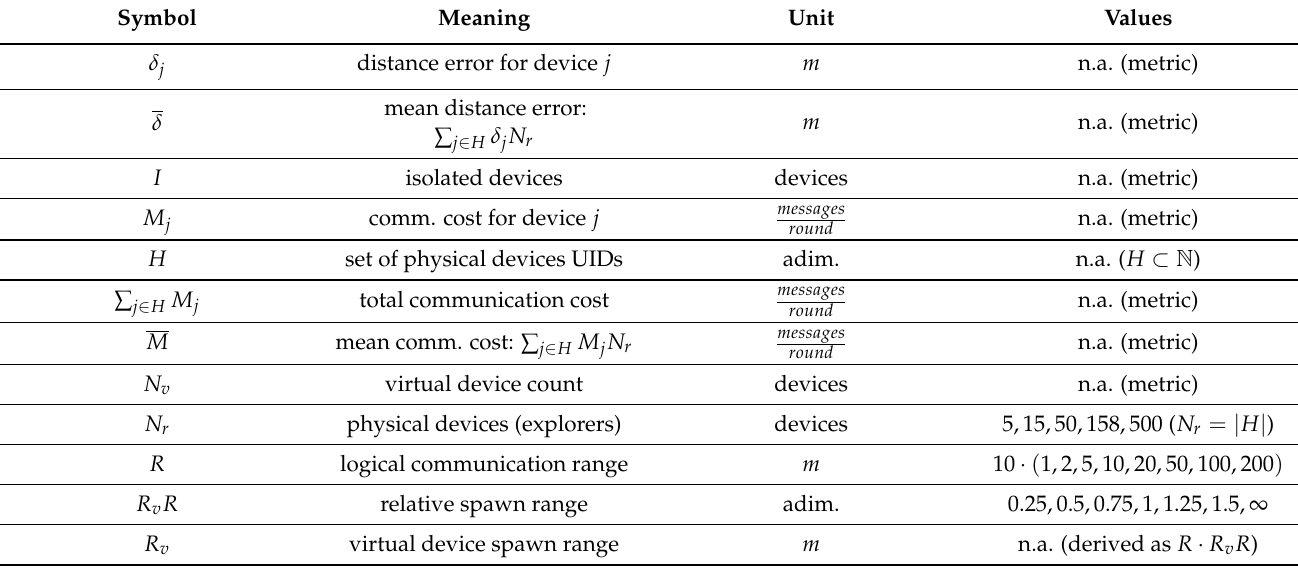
Table 4. Summary of all symbols used in the